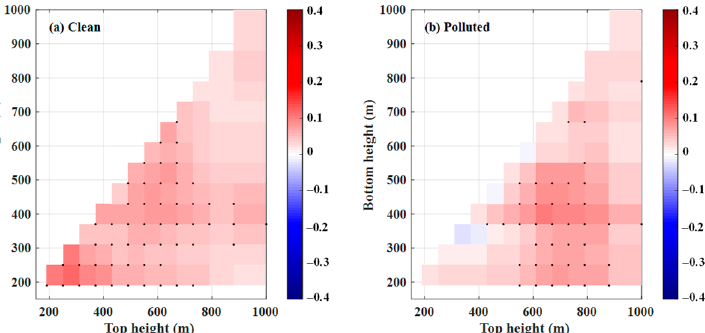
Figure 9. The distributions of correlation coefficients between NPM 2.5 and VWS under ( a ) clean and ( b ) polluted conditions in JM. Black dots indicate the Pearson correlation coefficients passing the confidence level of 90%.